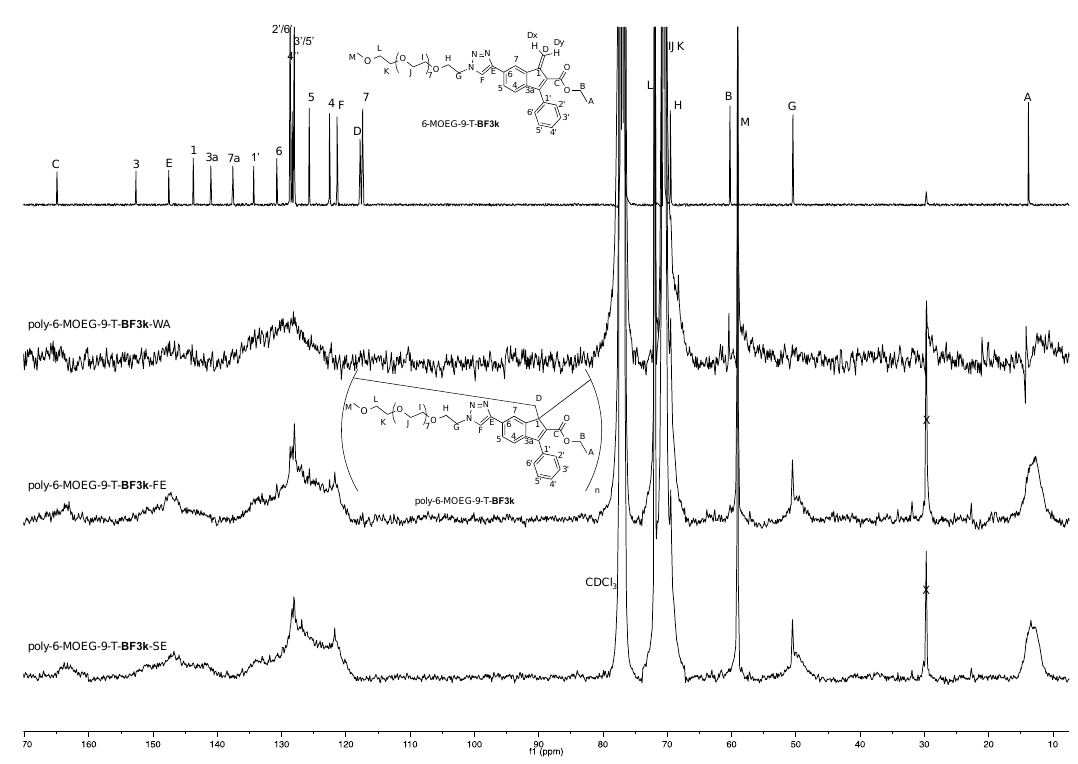
Figure 8. Comparison of the 13 C NMR spectrum of monomer 6-MOEG-9-T- BF3k (125 MHz, CDCl 3 , top trace) with those of the corresponding polymers: poly-6-MOEG-9-T- BF3k -WA, poly-6-MOEG-9-T- BF3k -FE, and poly-6-MOEG-9-T- BF3k